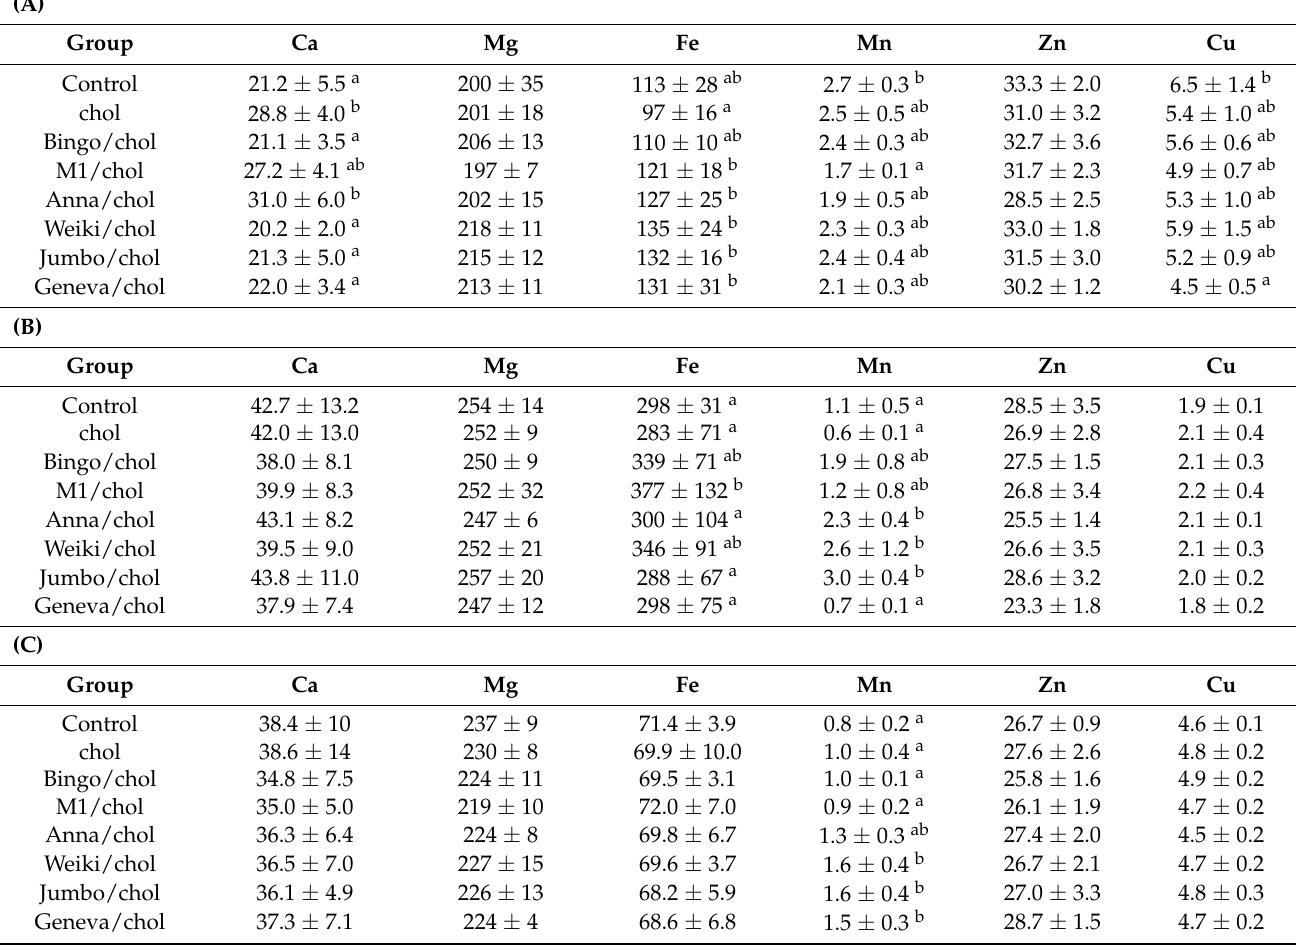
Table 3. Contents of minerals (mg · kg − 1 DM) in (A) livers, (B) spleens, and (C) kidneys of rats fed diets with kiwiberry fruits; mean ±